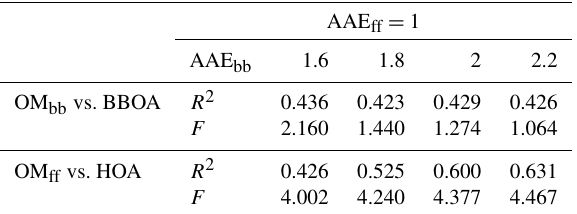
Table 3. Squared Pearson ( R 2 ) and slope ( F ) of the scatter plot between OM bb and BBOA and between OM ff and HOA, for differ- ent values of AAE bb (1.6, 1.8, 2, 2.2) keeping AAE ff = 1 at MSY (hourly